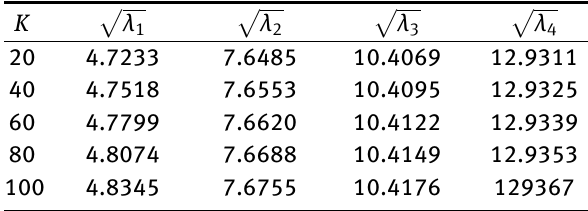
Table 24: Frequency parameter Winkler modulus parameter K